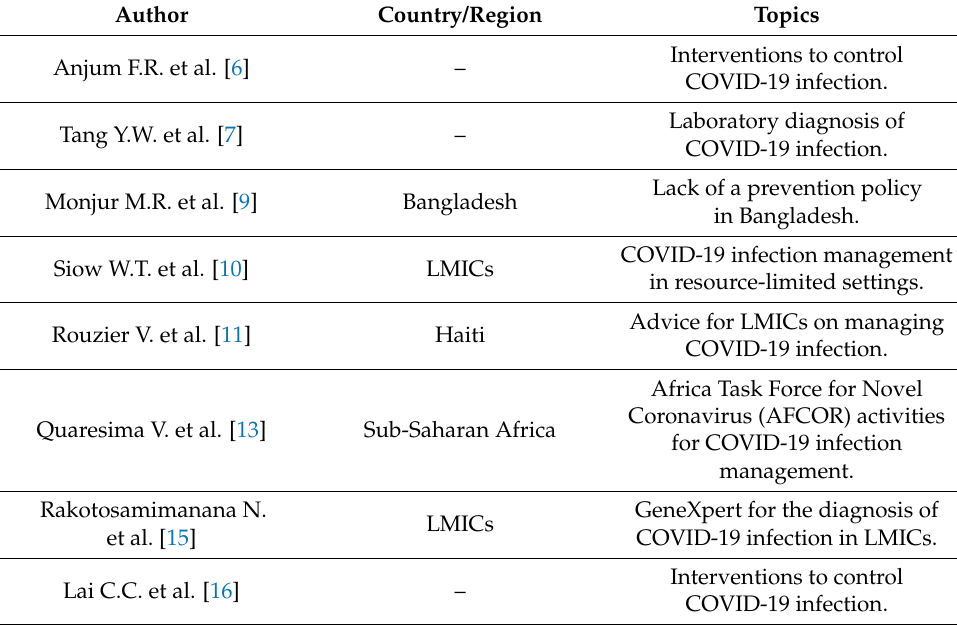
Table 1. Infection prevention and control; triage; infrastructure and Intensive Care Unit